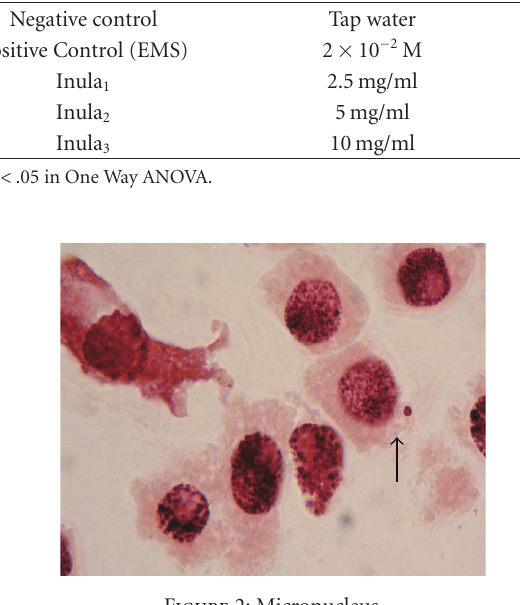
Figure 2: Micronucleus.